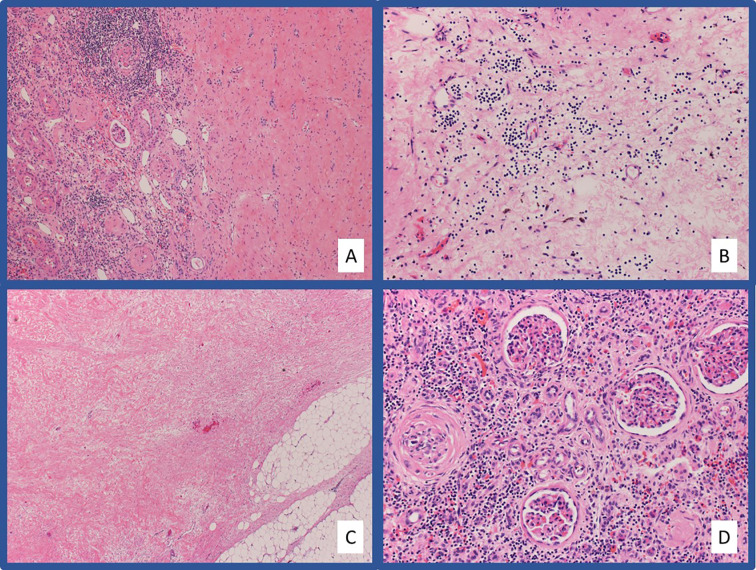
Representative pathologic images from Case #1 Hematoxylin and eosin (H&E) stained slides at low-power (A) and high-power (B) magnification showing extensive hyalinized fibrosis with scattered chronic inflammation and hemosiderin laden macrophages in the area of tumor regression. The fibrosis extends into the adjacent fibroadipose tissue (C). Chronic tubulointerstitial nephritis and globally sclerosed glomeruli are present in the adjacent residual benign renal parenchyma (D).